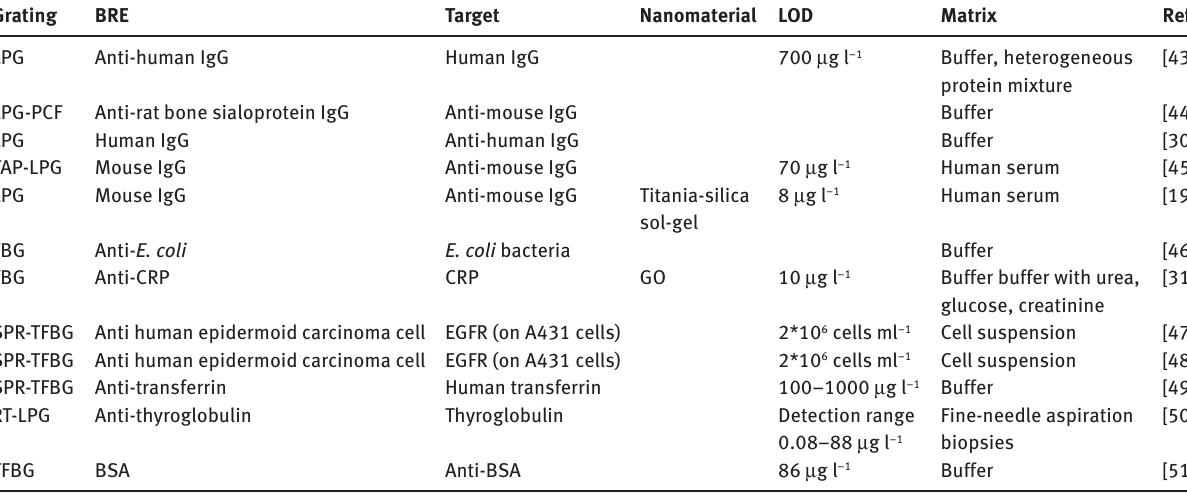
Table 1: OFG-based biosensors with antibodies as biological recognition elements (BREs). Grating BRE